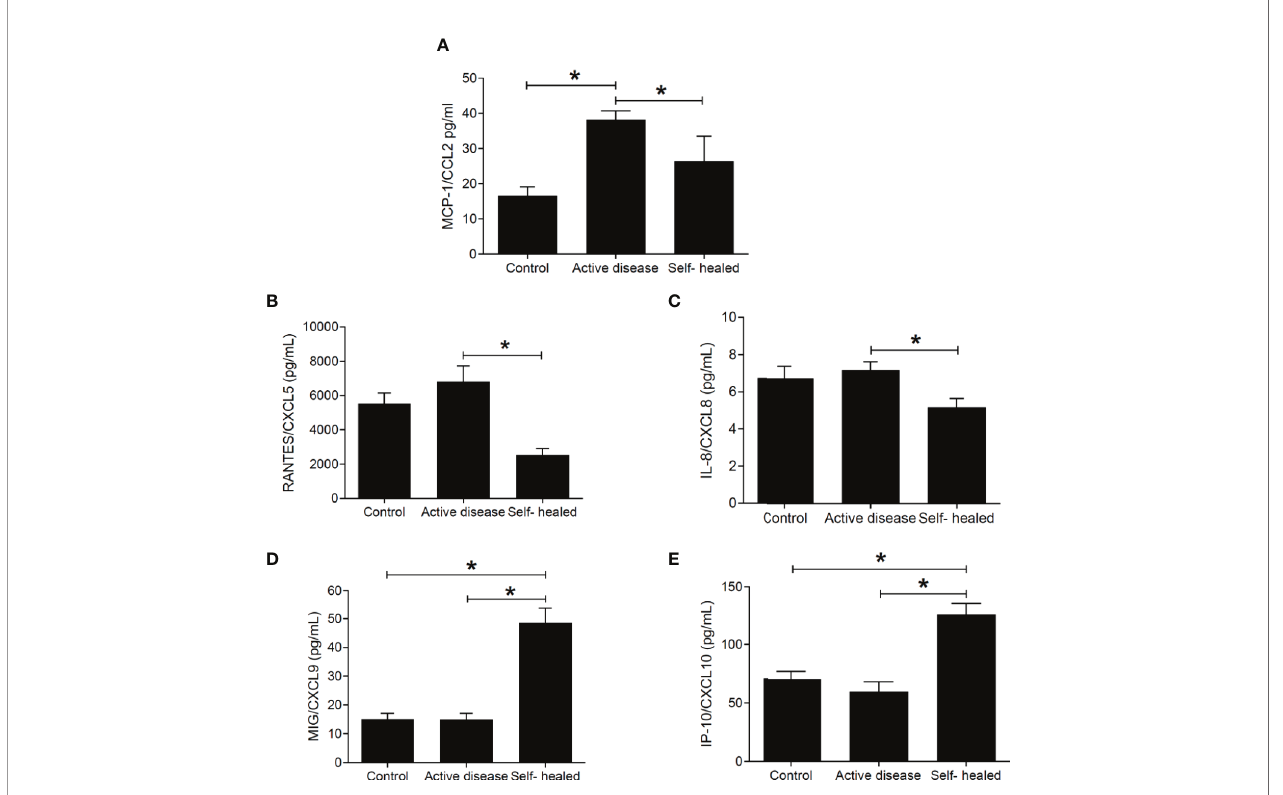
FIGURE 7 | Chemokine concentration (pg/ml) in plasma of cutaneous leishmaniasis patients and controls. MCP1/CCL2 (A) , RANTES/CXCL5 (B) , IL-8/CXCL8 (C) , MIG/CXCL9 (D) , and IP-10/CXCL10 (E) concentrations were measured by fl ow-cytometry using the CBA kit. * = p < 0.05 (Kruskal-Wallis and Bonferroni tests). N =5 patients and controls per